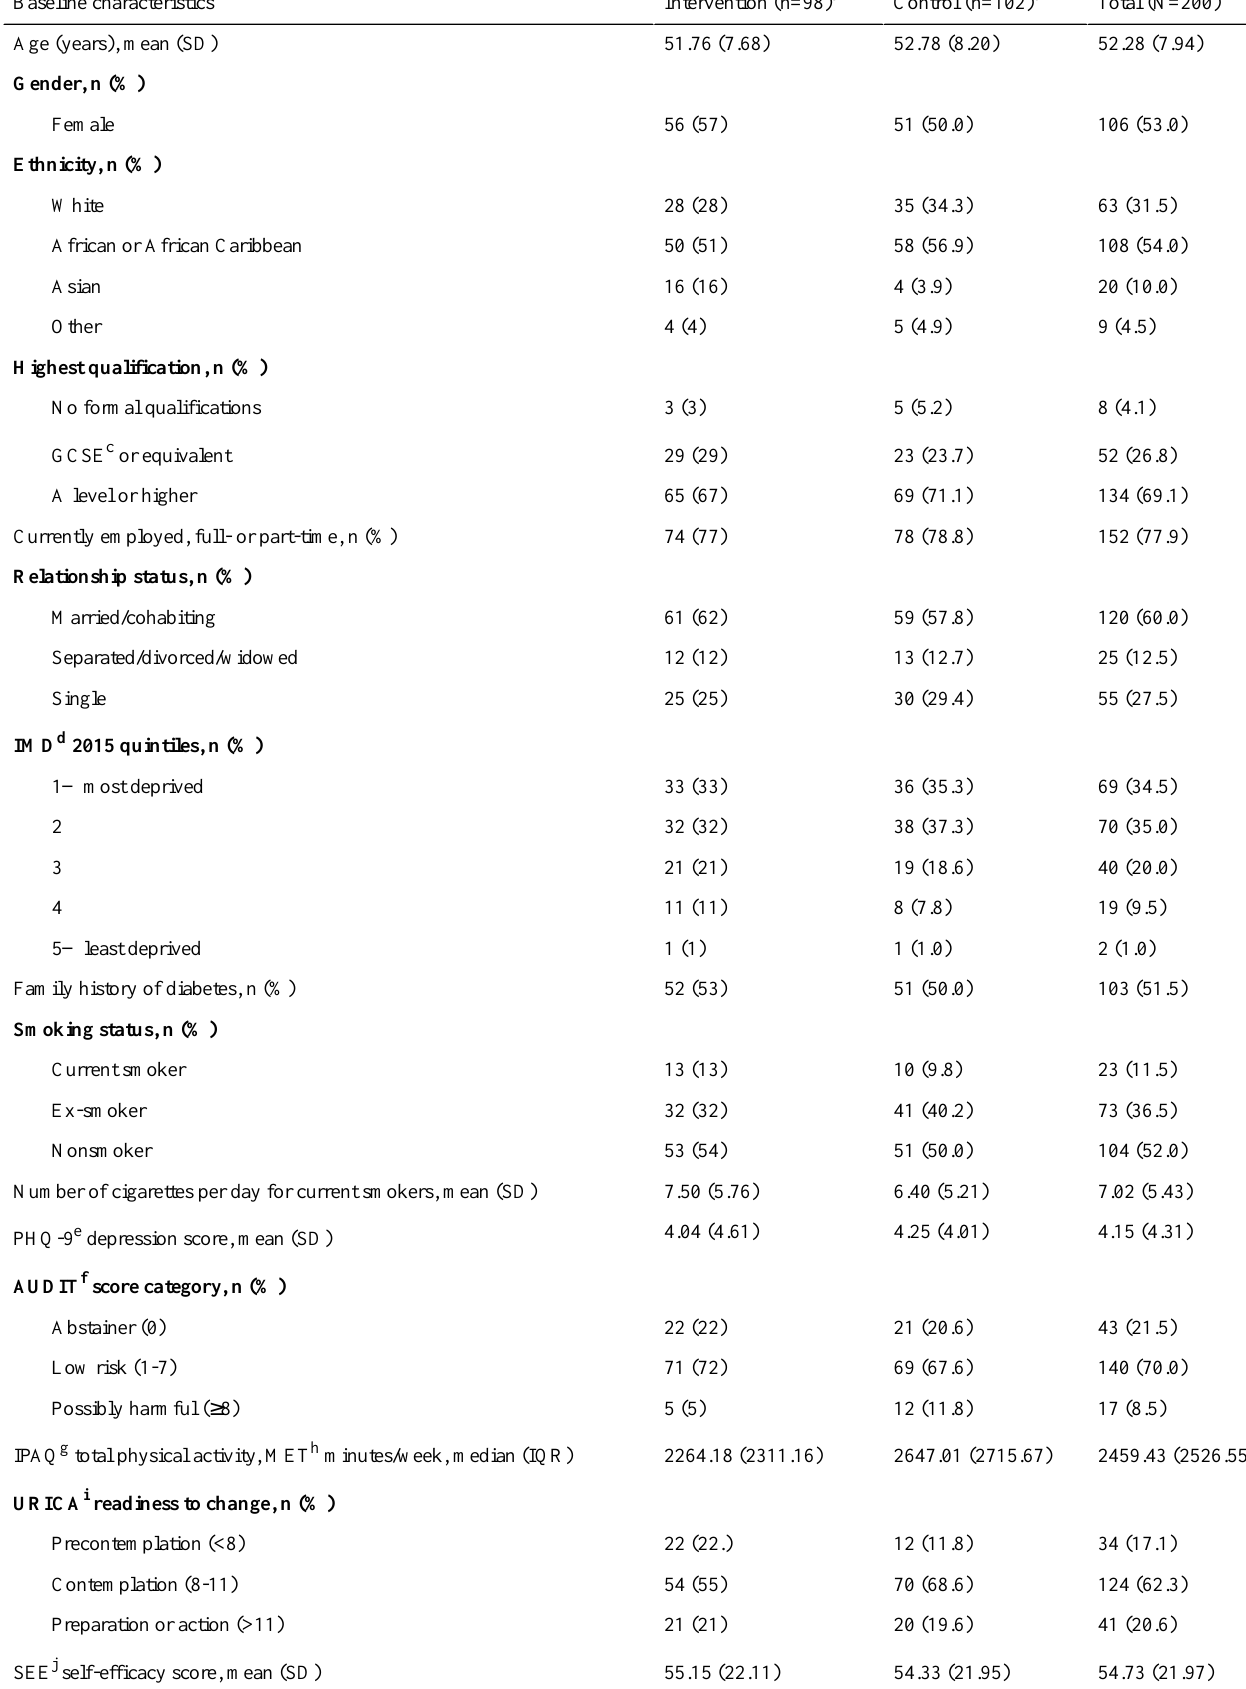
Table 1. Baseline